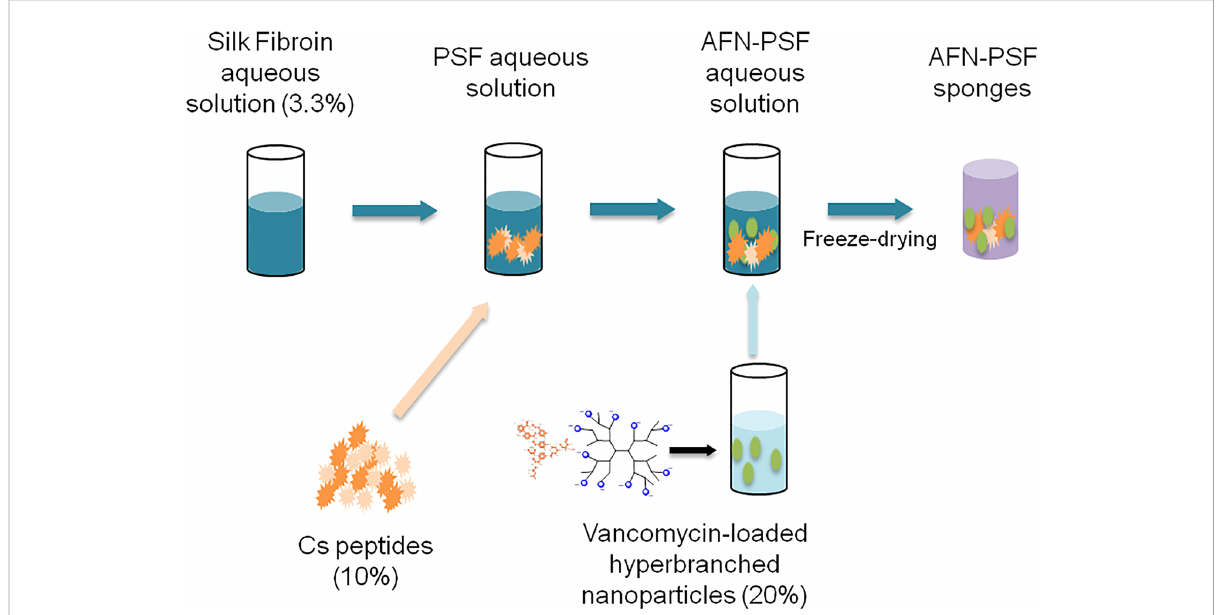
FIGURE 1 Schematic illustration of the development of peptide-enriched silk fi broin sponges loaded with vancomycin-loaded functionalized nanoparticles